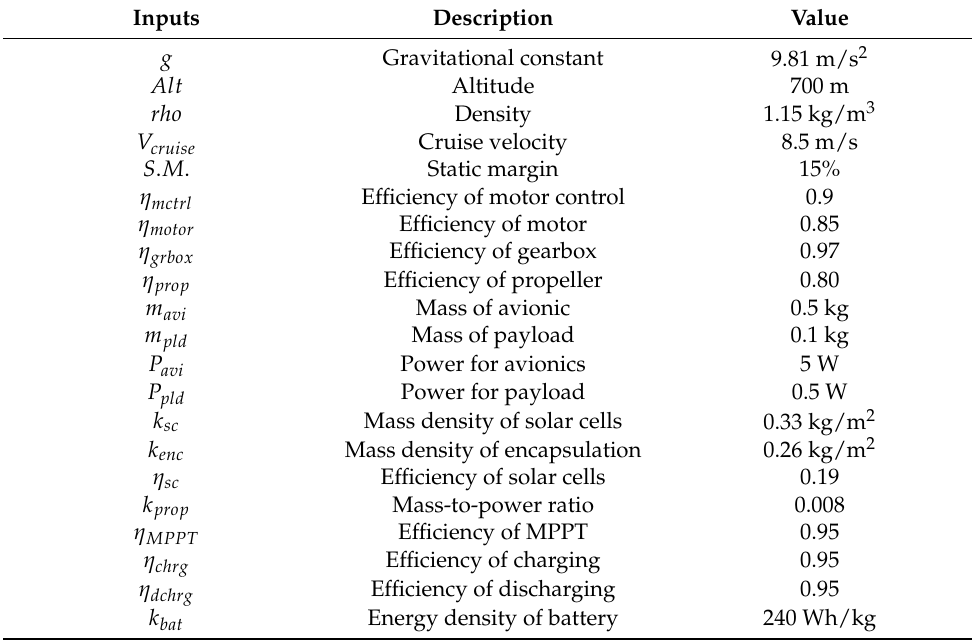
Table 5. Input parameters for solar UAV